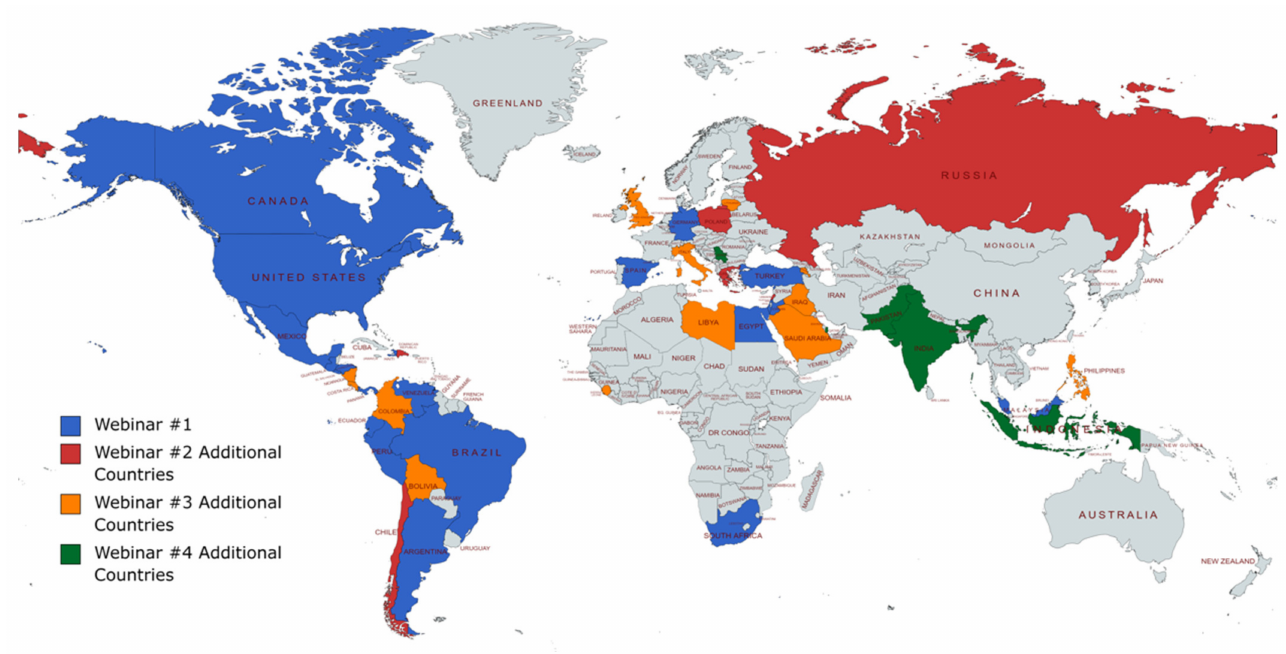
Figure 4. Geographical representation of the LBCH/SJCRH Pediatric Cardio-Oncology webinar